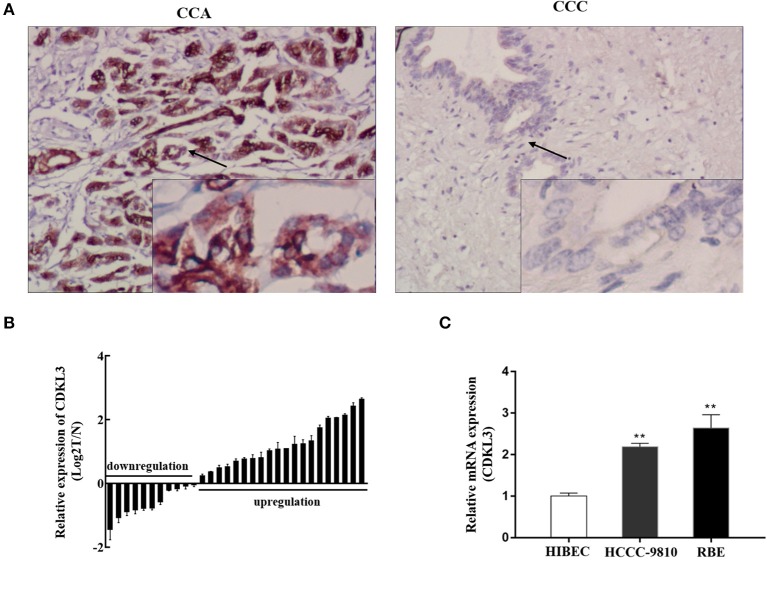
Expression of CDKL3 in human CCA tissues and established cell lines. (A) Expression of CDKl3 in human CCA tissues and control tissues was detected by immunohistochemistry. (B) Expression of CDKL3 in 31 pairs of tumor samples and matched adjacent noncancerous tissues was examined by qRT-PCR. (C) Expression of CDKL3 in human intrahepatic biliary epithelial cells (HIBECs) and 2 human cholangiocarcinoma cell lines (RBE and HCCC-9810) was examined by qRT-PCR. *P < 0.05, **P < 0.01, vs. HIBEC cells.